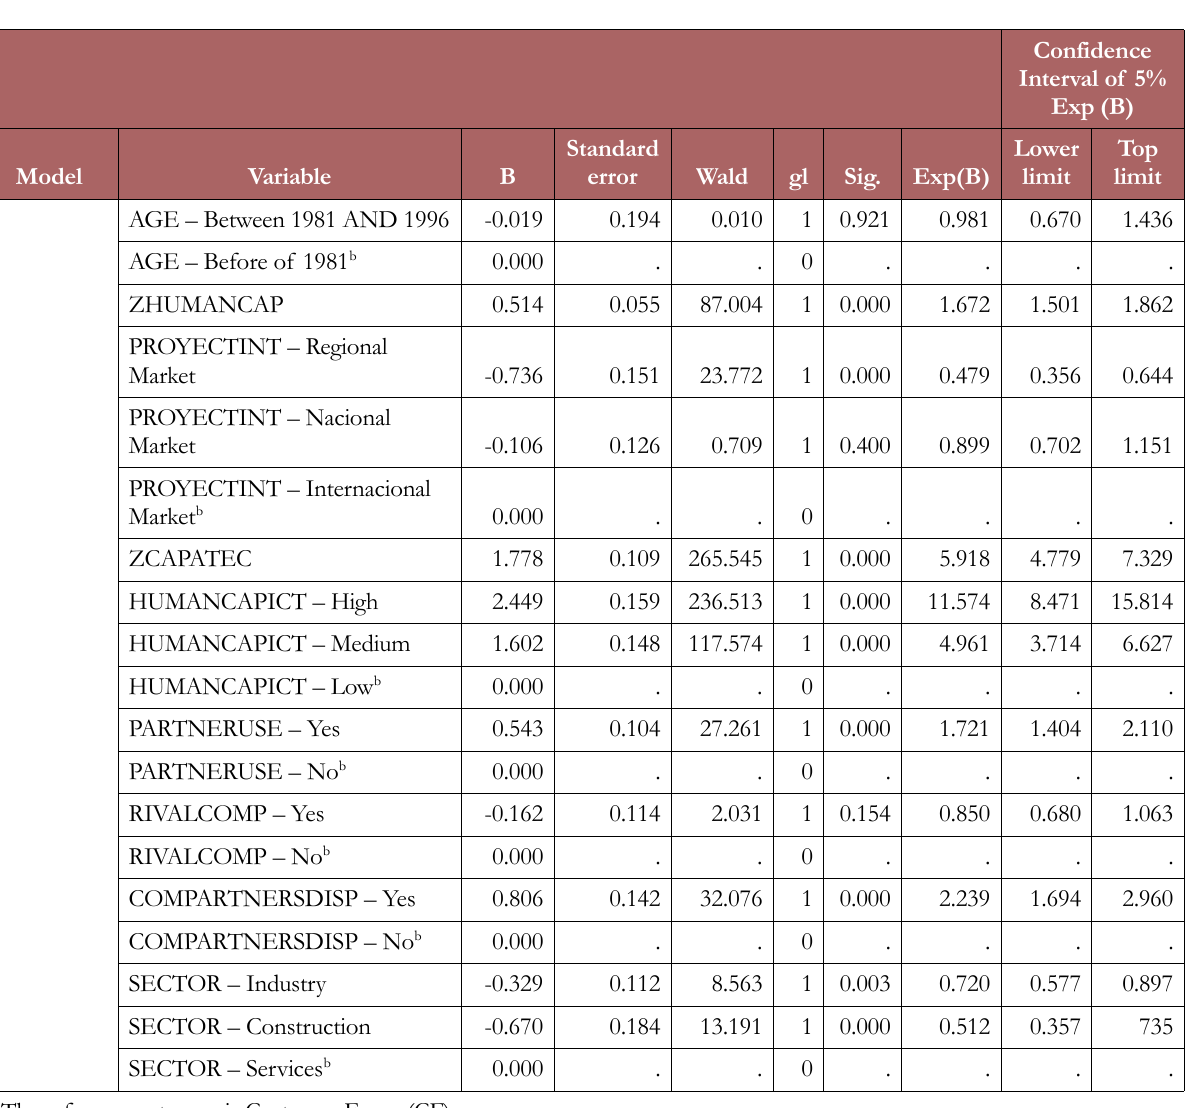
Table 9. Summary of results for estimating the Multinomial Logistic Regression model on e-Business